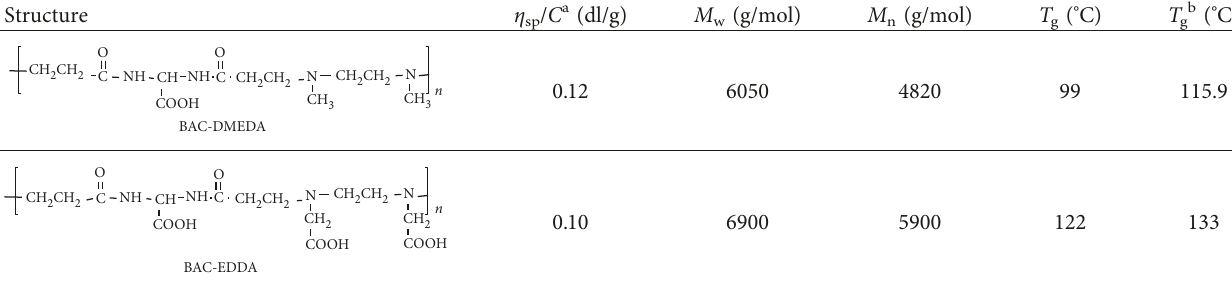
Table 1: Polymer structure, viscosity, molecular weights, and glass transition temperature.